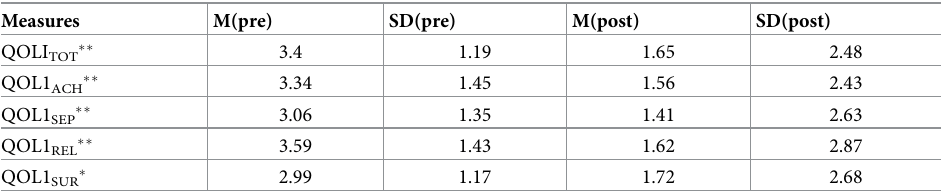
Table 1. Comparison of QOLI measures before and after social isolation. Measures M(pre) SD(pre) M(post) SD(post) QOLI TOT